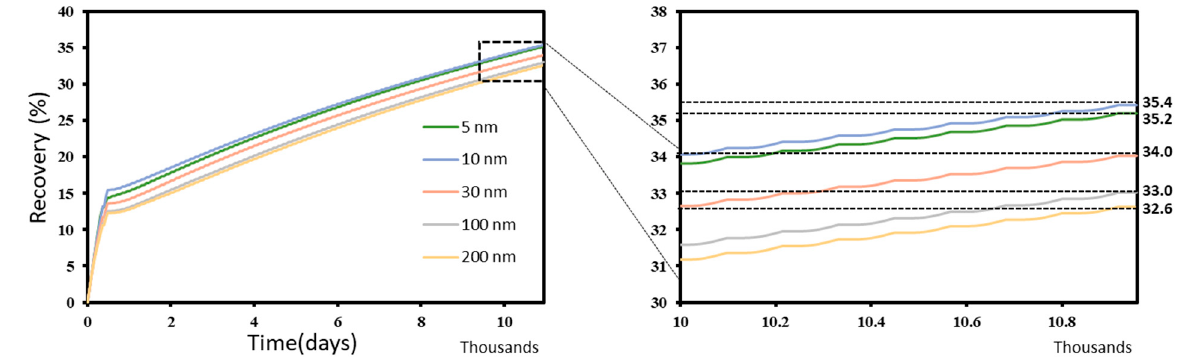
Figure 12. Recovery percentage over time for different pore confinements.